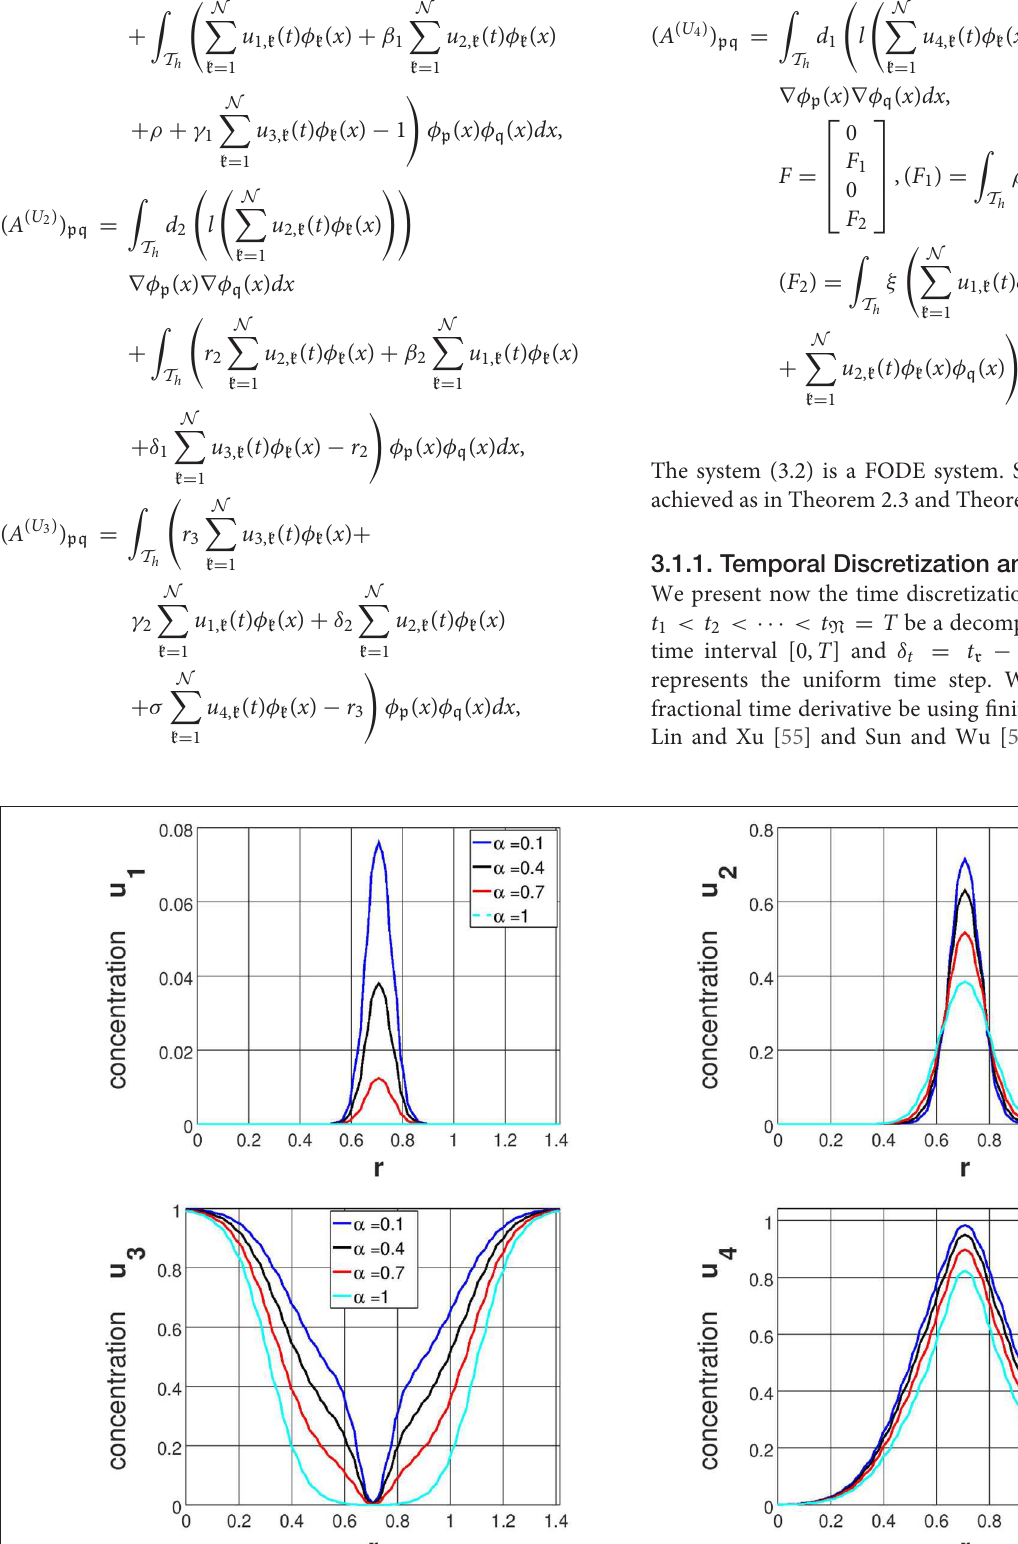
Frontiers in Physics |